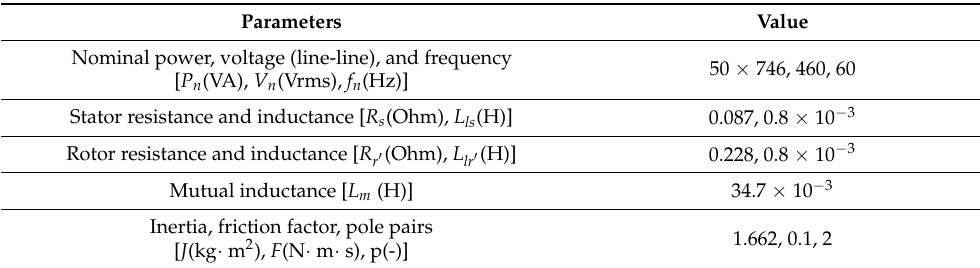
Table 1. Parameters of the induction